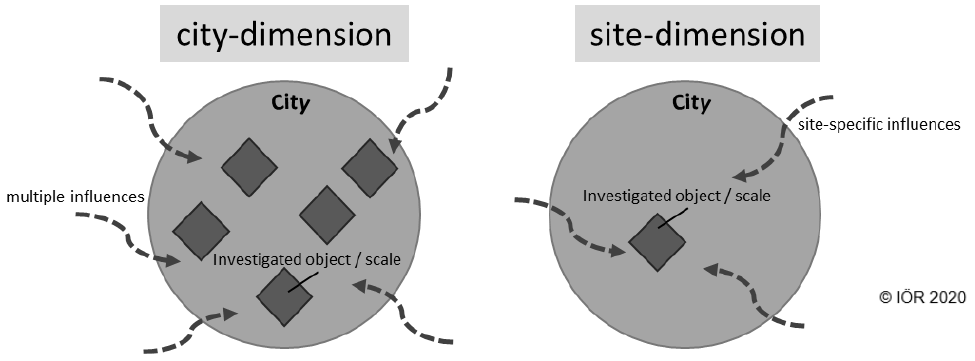
Figure 1. Schematic illustration of the assignment of studies to city- or site-dimension.